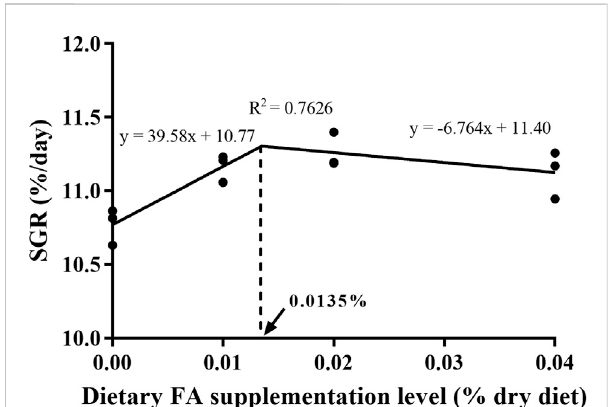
FIGURE 1 Relationshipofspeci fi cgrowthrate(SGR,%/d)withsupplemental FA levels of large yellow croaker larvae.